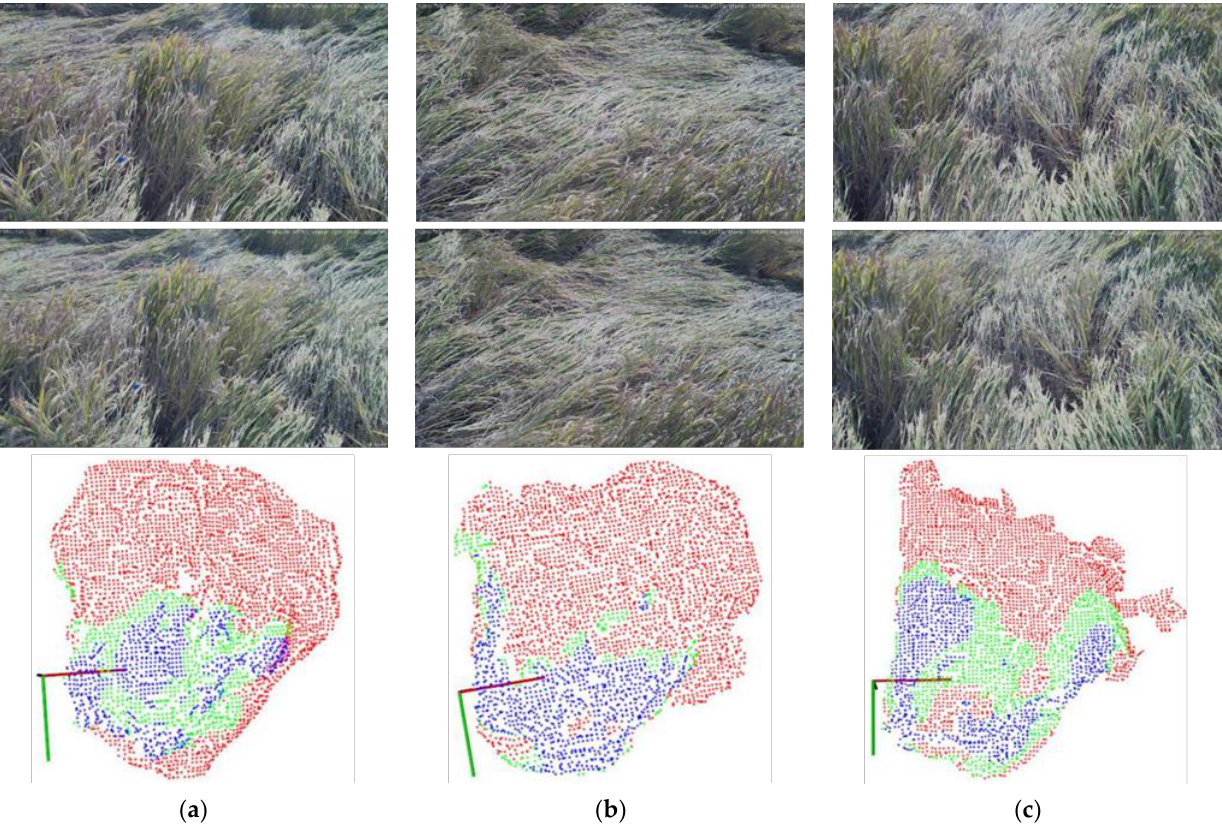
Figure 14. Analysis results of the wheat lodging area. ( a ) Lodging area proportion: 66.60%, inclined area proportion: 15.91%, upright area proportion: 17.474%; ( b ) Lodging area proportion: 66.9973%, inclined area proportion: 7.10235%, upright area proportion: 22.9004%; ( c ) Lodging area proportion: 54.0821%, inclined area proportion: 23.8496%, upright area proportion: 22.0683%.